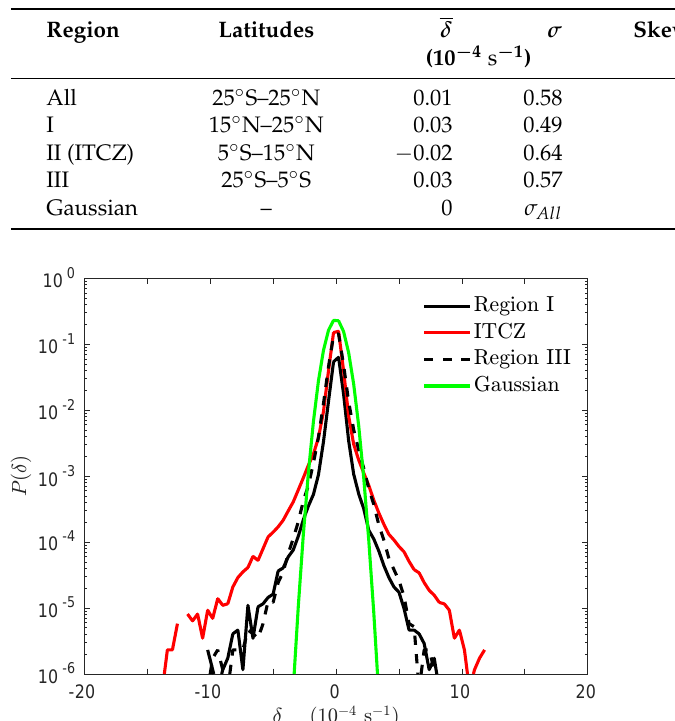
Table 1. Moments of P ( δ ) for three regions (Figure 6) and for all data.